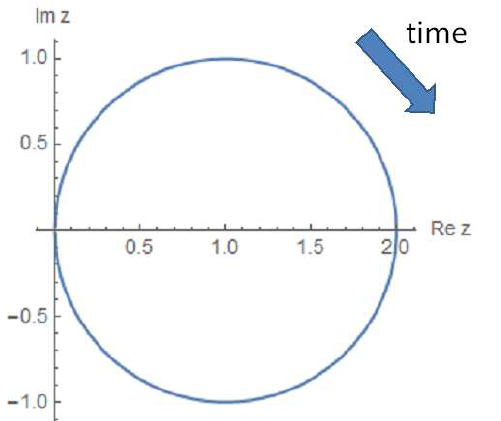
Figure 3 . The time evolution of cross ratio z